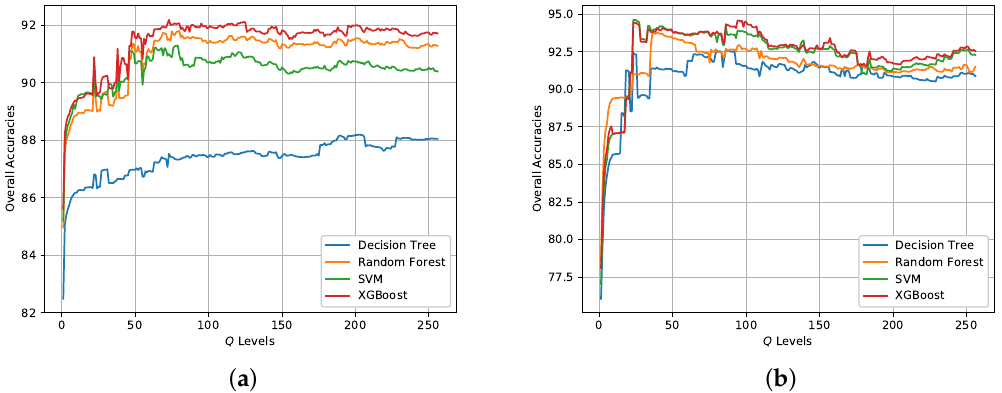
Figure 12. Classification results of different Q levels in SRM for the two data sets. ( a ) Data set A. ( b ) Data set B. Table 4. Q levels with the best overall accuracies (OAs) on data set